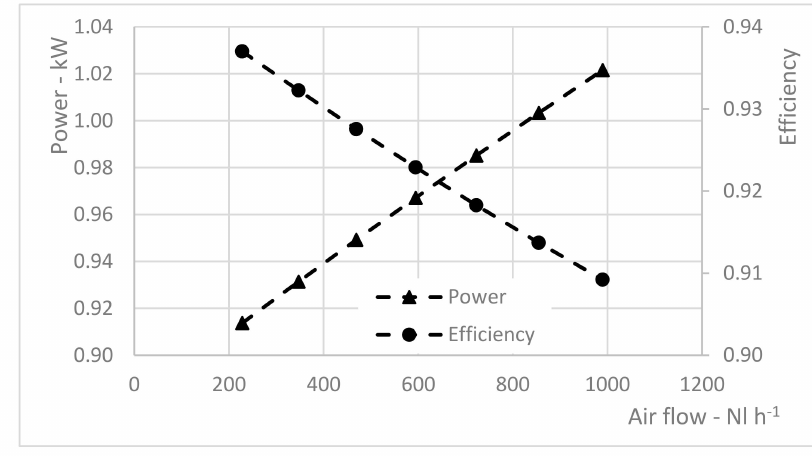
Figure 7. Power and efficiency as function of air flow